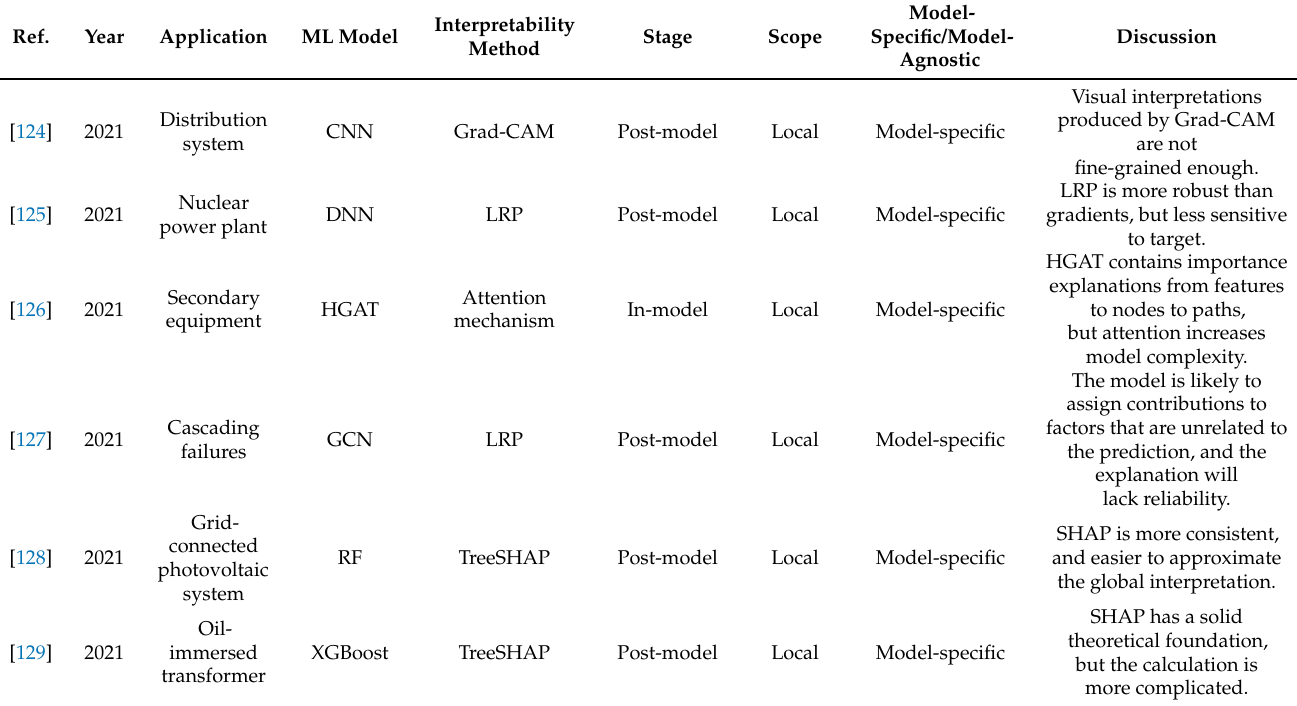
Table 2. Summary of interpretable ML for fault